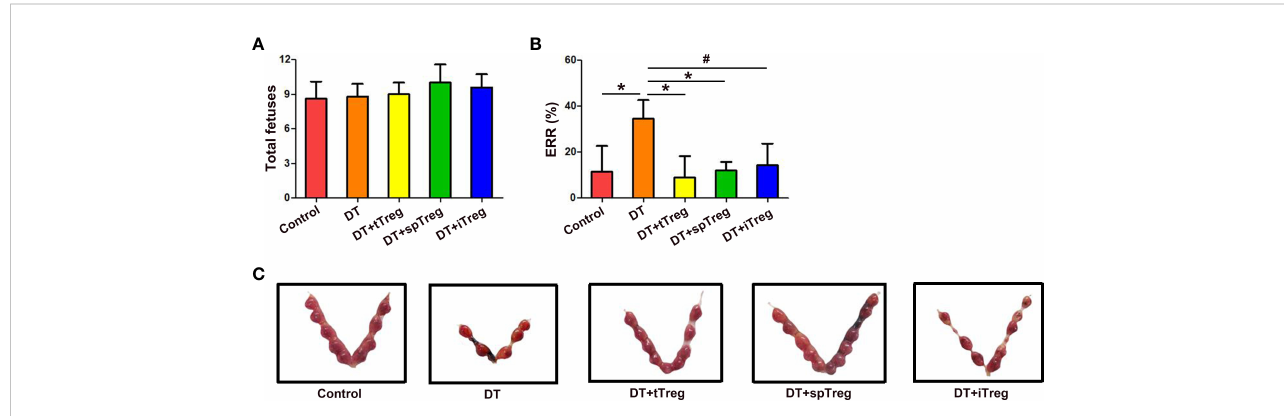
FIGURE 6 Adoptive transfer of Treg cells inhibits DT-induced pregnancy loss in Foxp3 GFP mice. The number of total fetuses (A) and ERRs (B) were calculated. Data are presented as mean ± SD (n = 8). * p < 0.01, # p < 0.05. (C) A representative macroscopic view of fetuses from mice that received vehicle, DT, DT plus tTreg cells, DT plus spTreg cells, or DT plus iTreg cells is shown. spTreg, spleen Treg